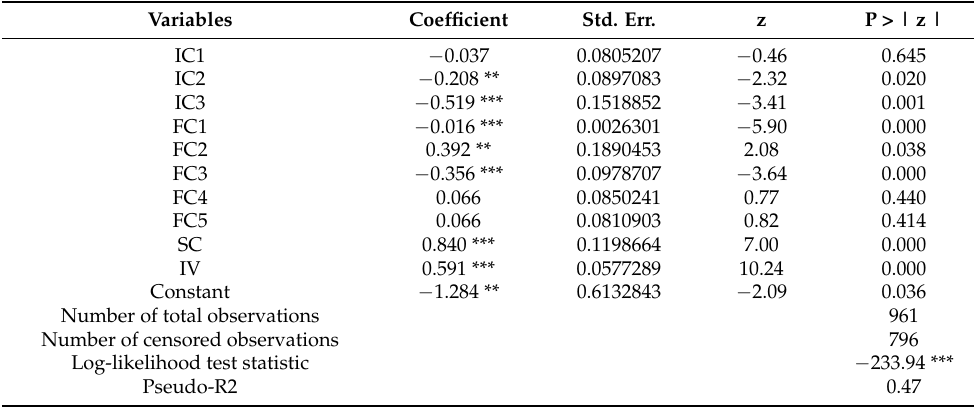
Table 4. First stage probit regression for predicting purchasing